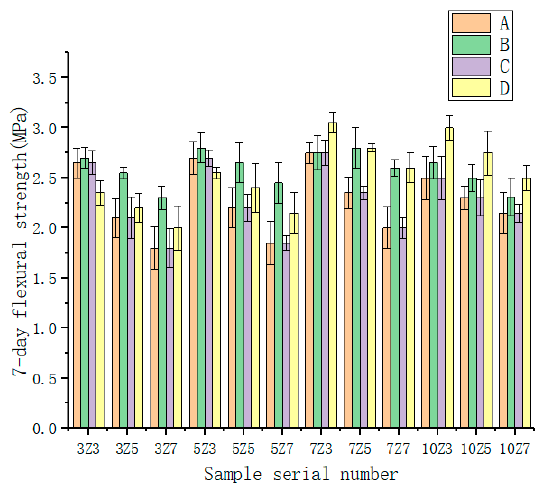
Figure 4. Flexural strength of water-retentive mortar in di ff erent SAP types.